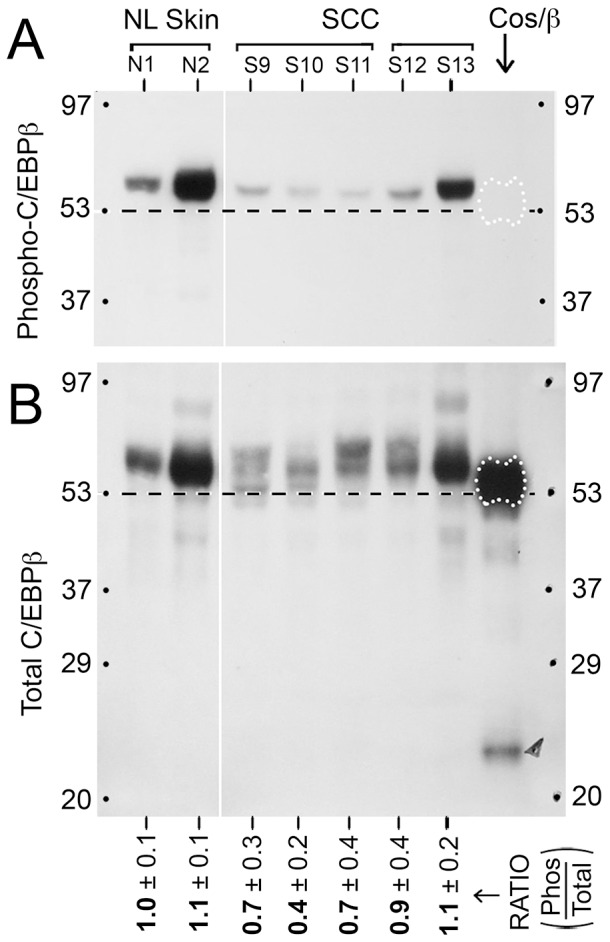
C/EBPβ-1 is phosphorylated at threonine-235 in human SCC.Western blots from the same lysates used in Fig. 3 were run and developed with antibodies to either: (A) phospho-C/EBPβ (Thr235), or (B) total C/EBPβ. The last lane contains lysates from cos-7 cells transfected with full-length human C/EBPβ vector. Dashed lines indicate the approximate location of recombinant C/EBPβ-2 to facilitate comparisons between the tumor lysates. MW markers in kD are indicated. Bottom, ratio of phosphorylated-to-total C/EBPβ (mean ± range) from densitometry of two western blot analyses.